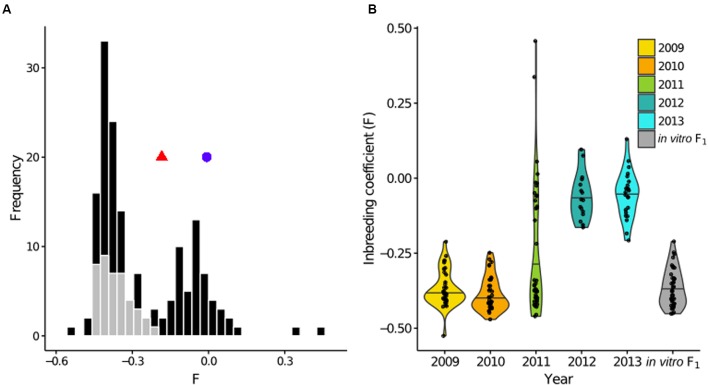
Generational shift in the field population. (A) Superimposed histograms of the individual inbreeding coefficient (F), estimated from 6,916 SNPs, in the in vitro F1 (gray) and field population (black). The in vitro F1 were more heterozygous than the founding parental isolates, corresponding to more negative F-values, indicated by a blue circle (A1 parent) and red triangle (A2 parent). In contrast, the field population exhibited a bimodal F distribution. (B) Distributions of F by year represented by violin plots, with each year shown in a distinct color and individual data points overlaid. The long upper tail of the 2011 distribution is driven by two field selfs.